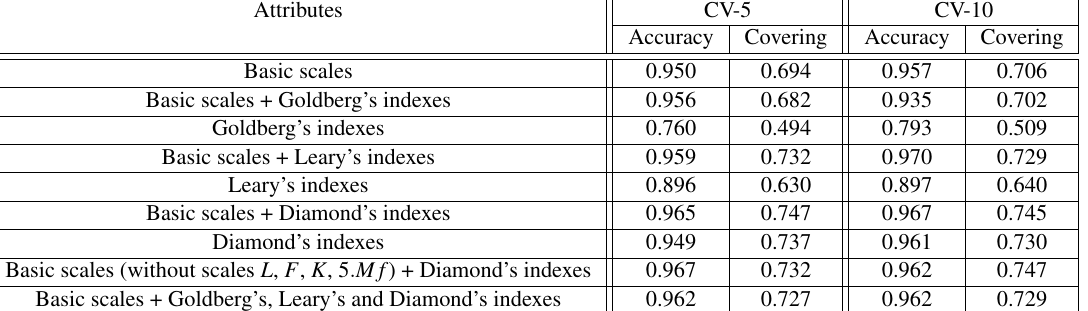
Table 4: Results of experiments using the LEM2 algorithm